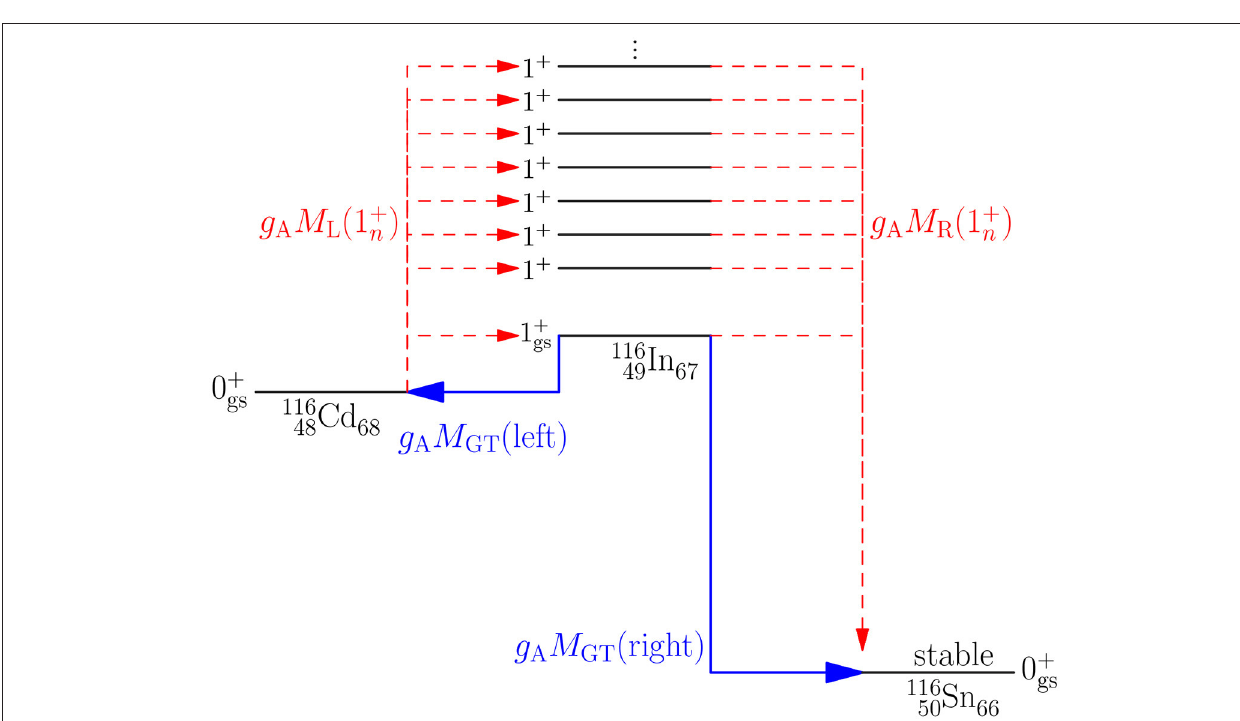
FIGURE 1 | Schematic representation of the β and 2 νββ transitions in the mass A ground state of the final nucleus 116 Sn and the 1 + states of the intermediate nucleus 116 In of the 2 νββ decay. Also the left-branch and right-branch NMEs for both decay modes are